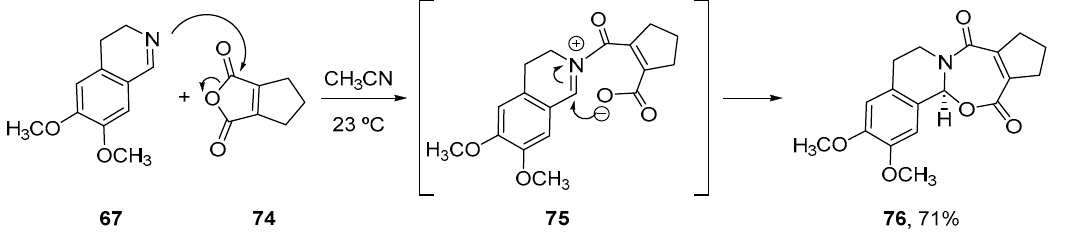
Scheme 26. The reaction of cyclopentane-fused maleic anhydride and the possible